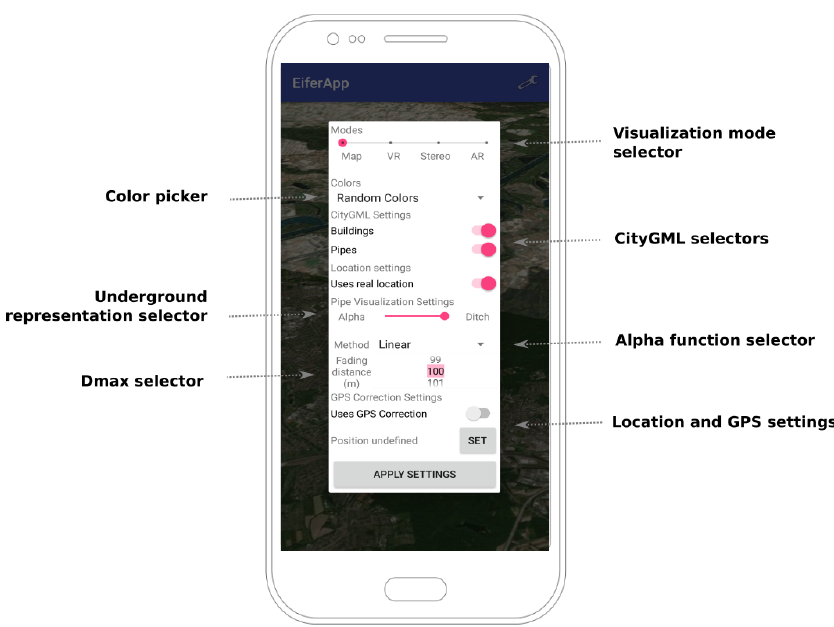
Figure 14. User interface layout for the survey in the Android platform. Underground-related selectors are added to the control